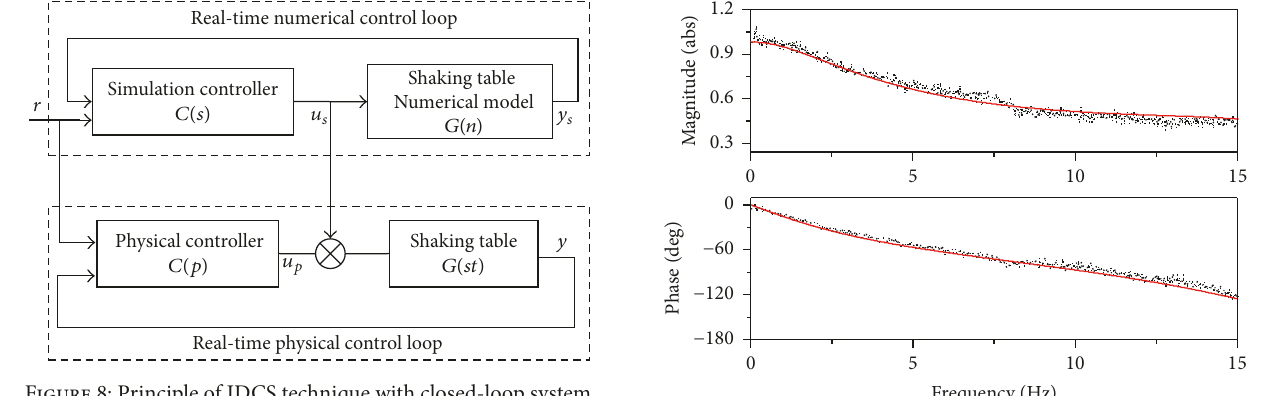
Figure 8: Principle of IDCS technique with closed-loop system.